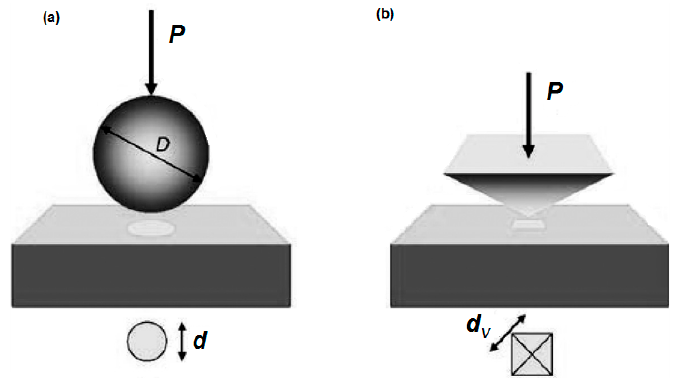
Figure 1. Commonly used methods of indentation hardness tests: ( a ) spherical indenter (Brinell and Meyer); ( b ) diamond pyramid (Vickers) [7]. Reproduced with permission from Ian M. Hutchings, Journal of Materials Research; published by Cambridge University Press,